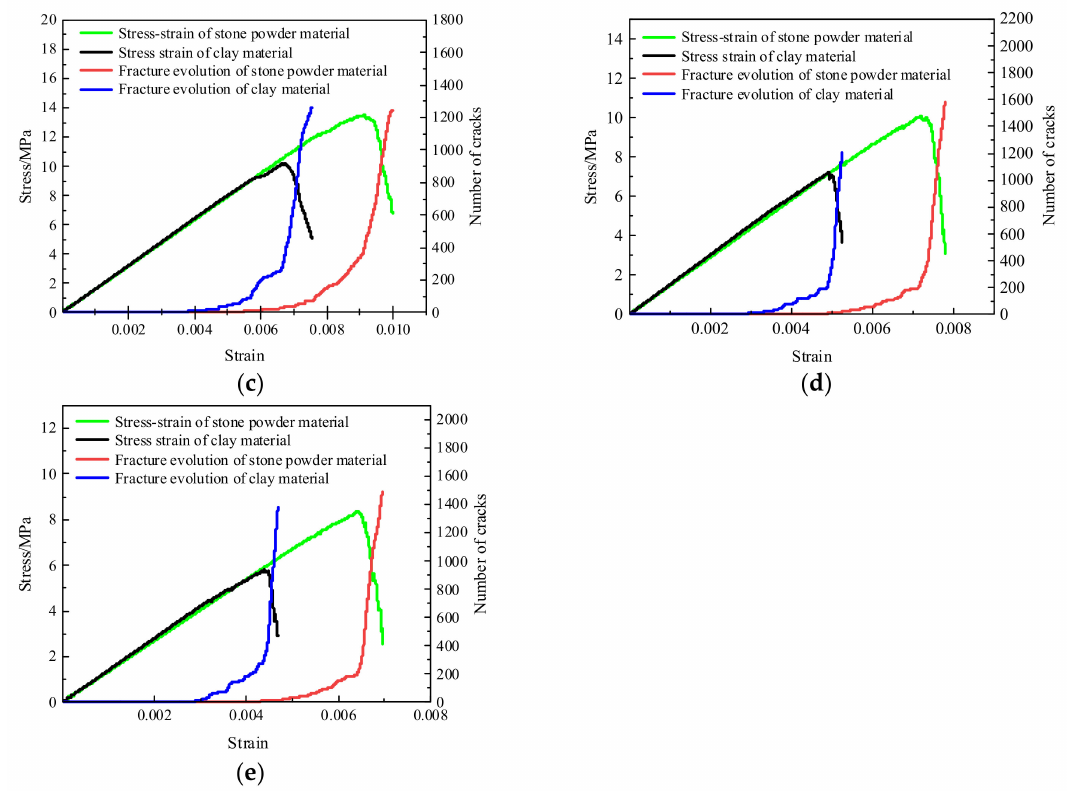
Figure 16. Stress-strain curves and crack evolution of different materials. ( a ) Curing pressure = 10 Mpa. ( b ) Curing pressure = 8 Mpa. ( c ) Curing pressure = 6 Mpa. ( d ) Curing pressure = 4 Mpa. ( e ) Curing pressure = 2